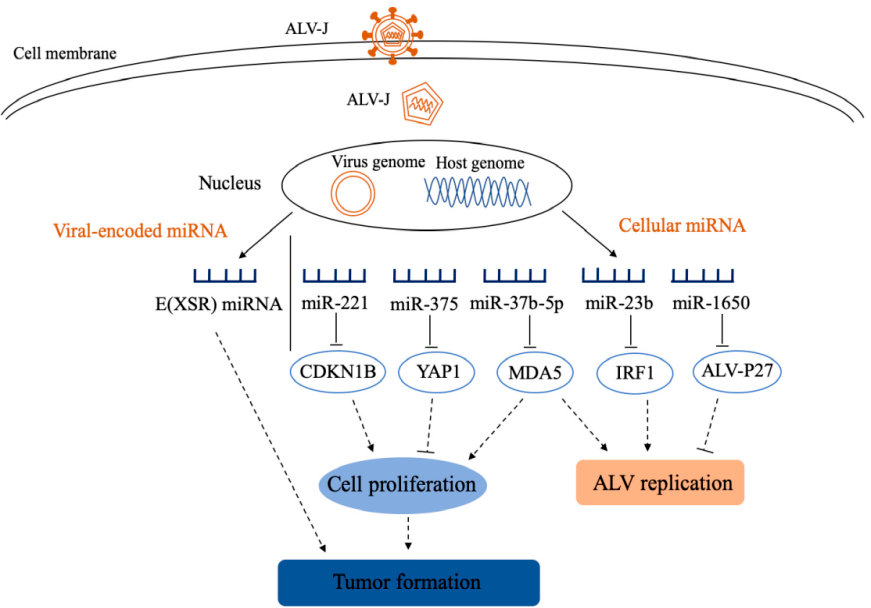
Figure 2. Schematic diagram of the roles of miRNAs in the pathogenesis of avian leukosis virus (ALV)-J infection. After ALV-J infection, viral-encoded miRNA and host miRNAs are involved in tumorigenesis and viral replication. CDKN1B: cyclin dependent kinase inhibitor 1B; YAP1: yes-associated protein 1; MDA5: melanoma differentiation associated gene 5; IRF1: interferon regulatory factor 1.